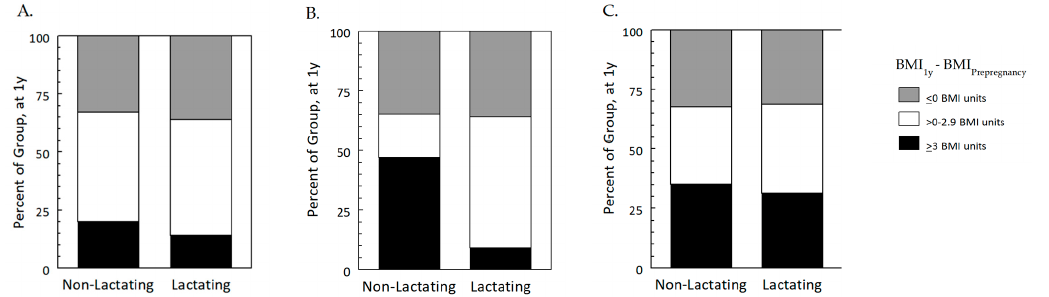
Figure 2. Percentage of lactating and non-lactating women who at 1 year postpartum ( n = 158) were the same BMI or less (< 25th percentile), 0.1–2.9 BMI units higher (25–75th percentile), or ≥ 3 BMI units higher (> 75th percentile) than prepregnancy, by prepregnancy (PPG) BMI group: ( A ), Prepregnancy Healthy Weight; ( B ), Prepregnancy Overweight; ( C ), Prepregnancy Obesity. In the Prepregnancy Overweight group ( B ), a greater percentage of non-lactating than lactating women were in the upper quartile, meaning they were ≥ 3 BMI units heavier than prepregnancy.